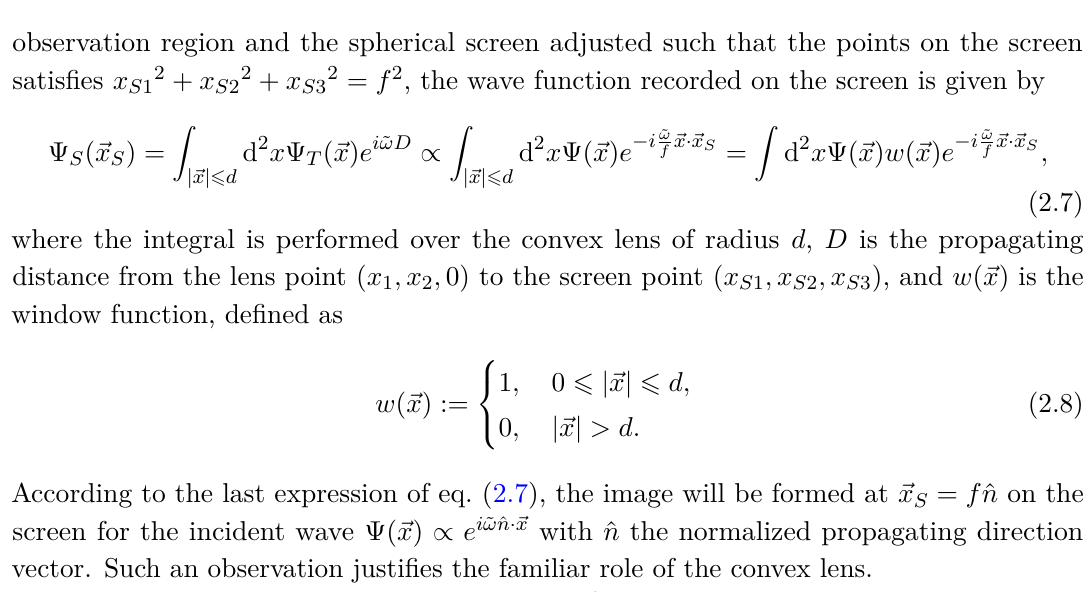
Figure 2 . The convex lens of radius d is put onto the observation region and the screen is adjusted at the focus of the convex